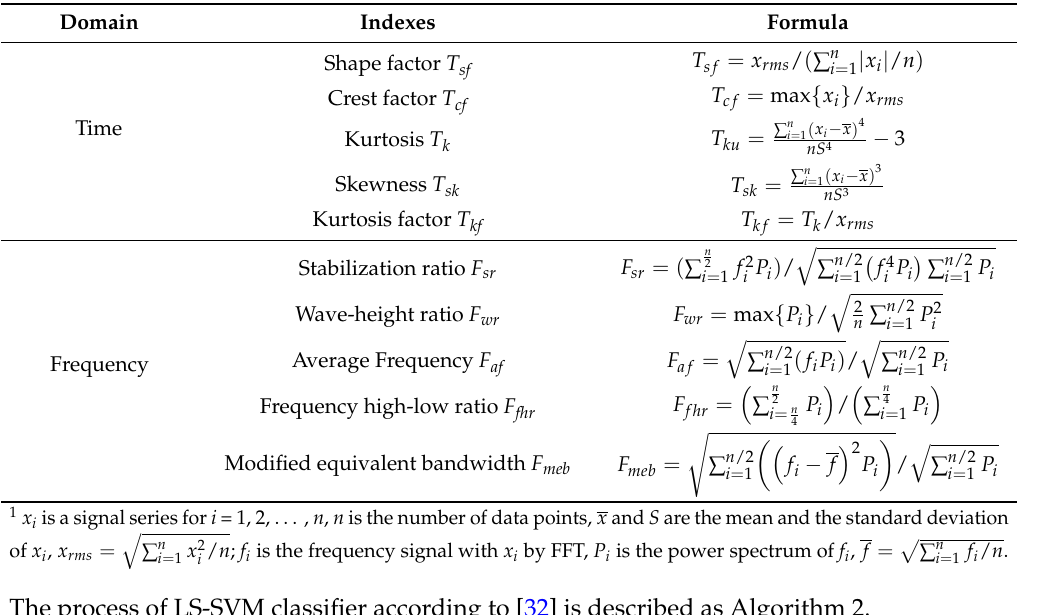
Algorithm 2. Training LS-SVM classifier by leave-one-out cross validation corresponding to the i -th